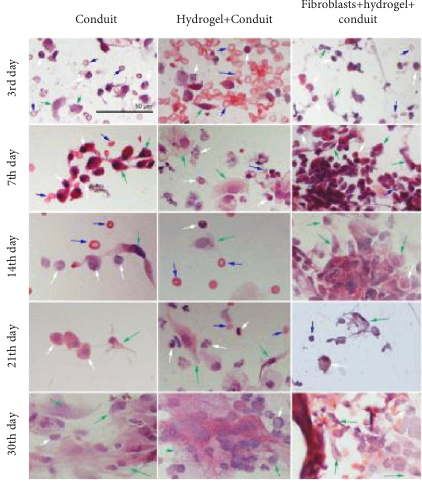
Figure 8: Observation diagram of coating preparation containing artificial nerve components obtained after